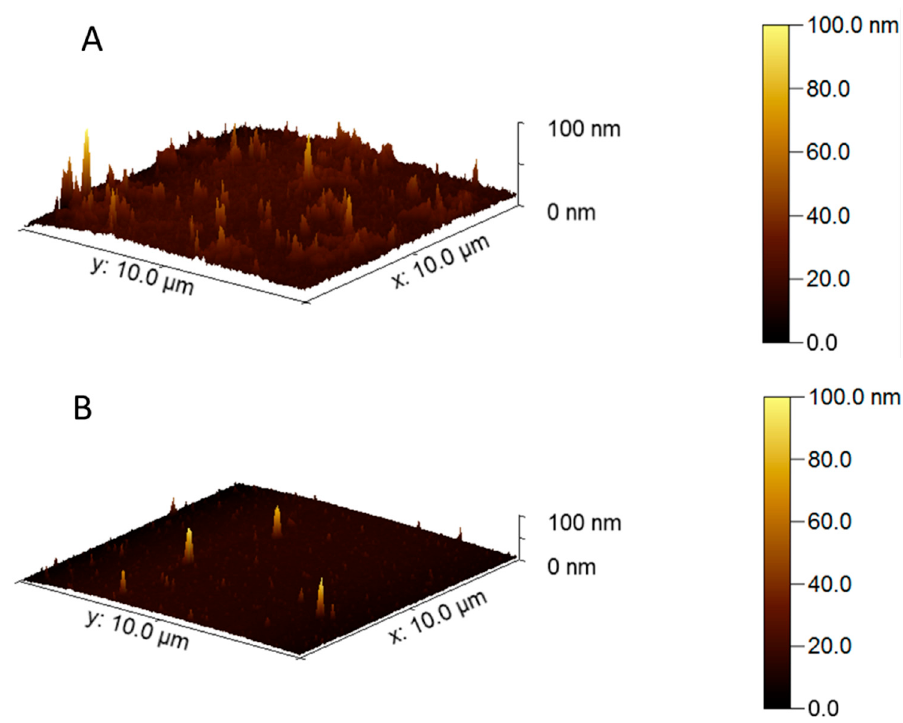
Figure 6. Atomic force microscopy of ( A ) B6,5 and ( B ) B6,5 + RG4 demonstrating disaggregation of B6,5 dye by RNA G-quadruplex.